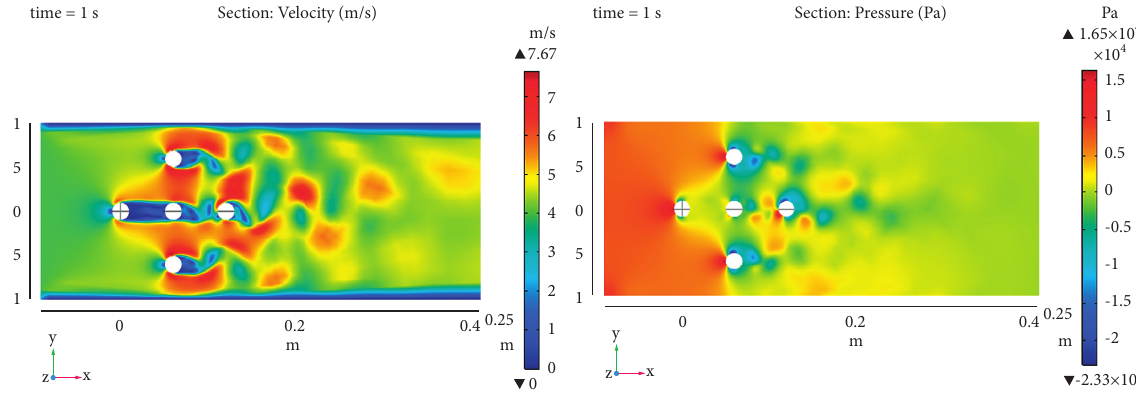
Figure 27: Velocity and pressure nephogram of XY